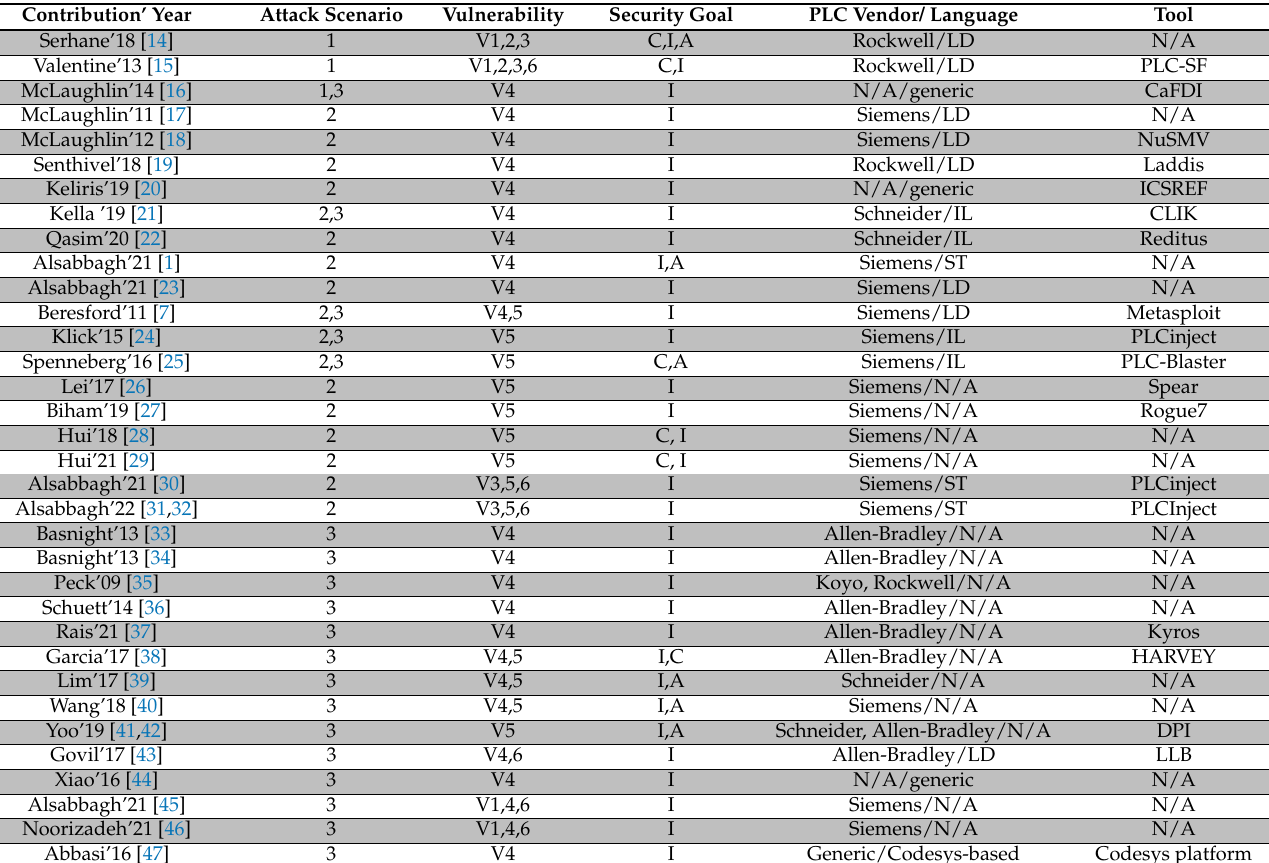
Table 1. The studies investigating control logic injection